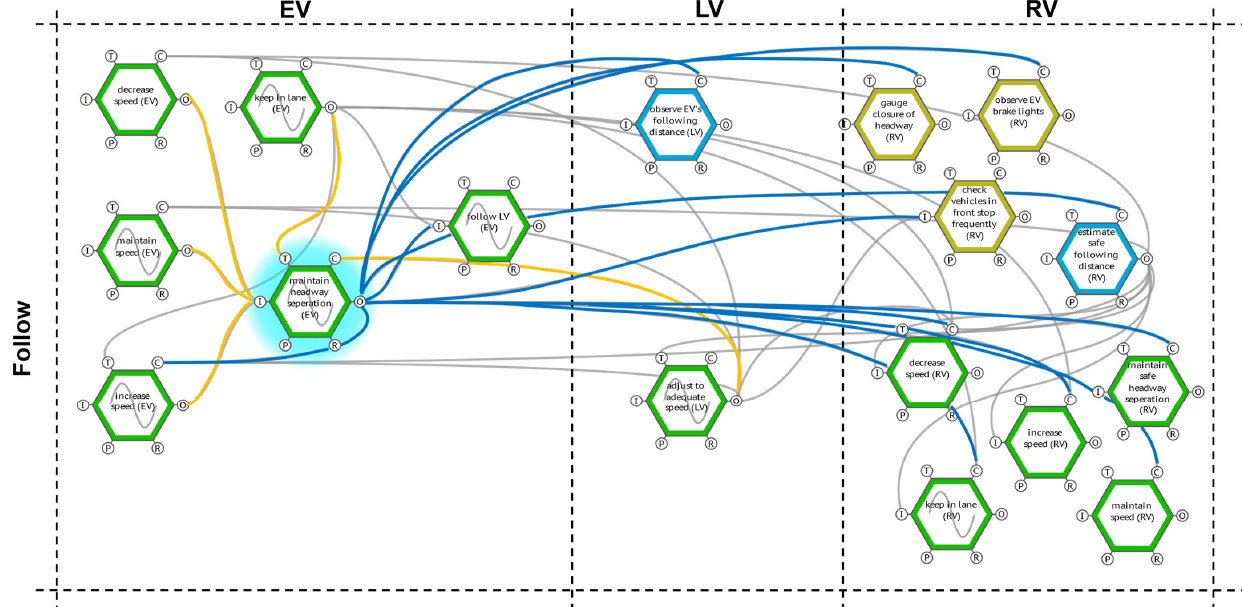
Figure 13. The critical path of the function < maintain headway separation (EV) > for the human driver. man